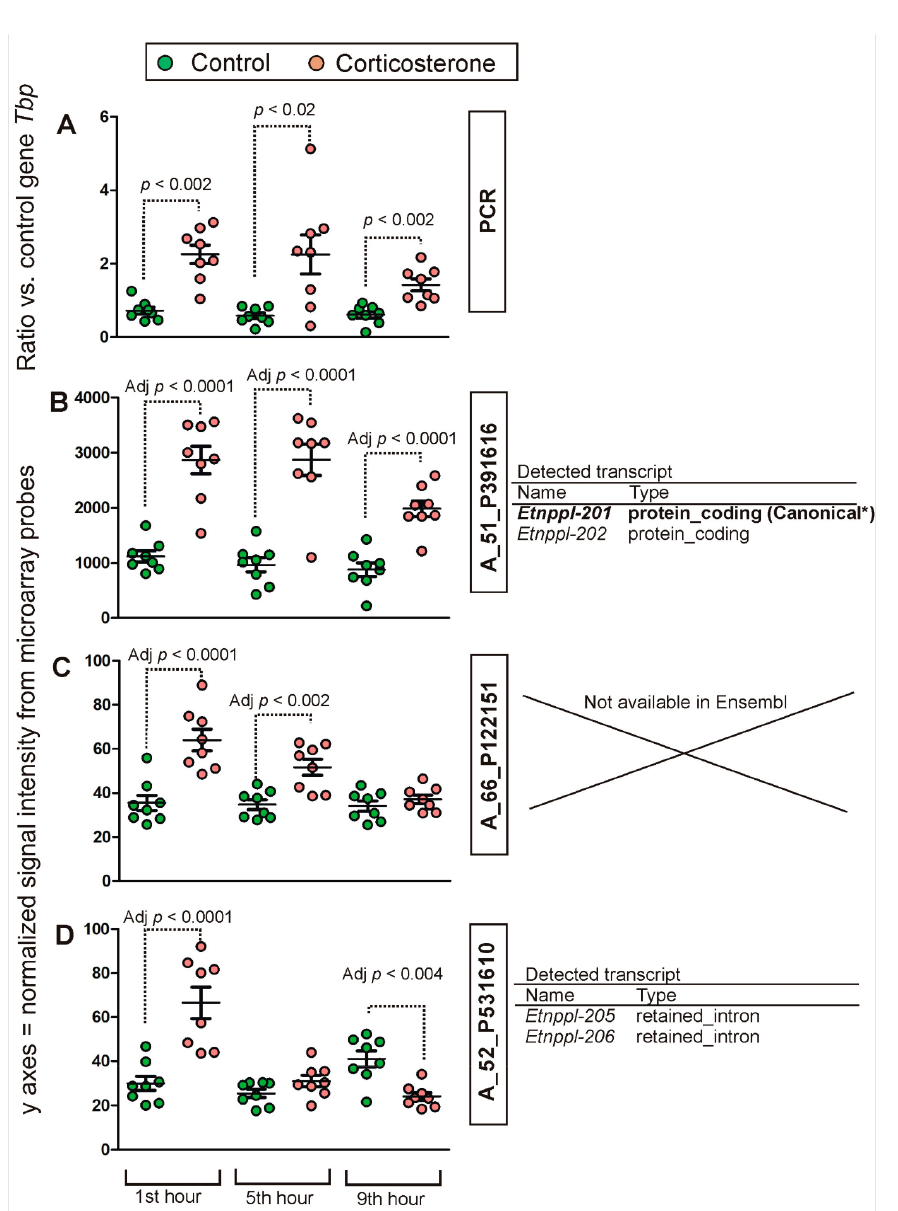
Figure 5. Between-group comparison of Etnppl expression detected with PCR ( A ) and different microarray probes ( B – D ). p values were determined based on Mann–Whitney U test applied to microarray PCR results ( A ) and separate channel test applied to microarray data ( B , C ). The right panel provides information about transcript variants (Ensembl/BioMart database) that can be detected by the probes. *—Ensembl canonical transcript having the highest coverage of conserved exons, highest expression, longest coding sequence and represented in other key resources, such as